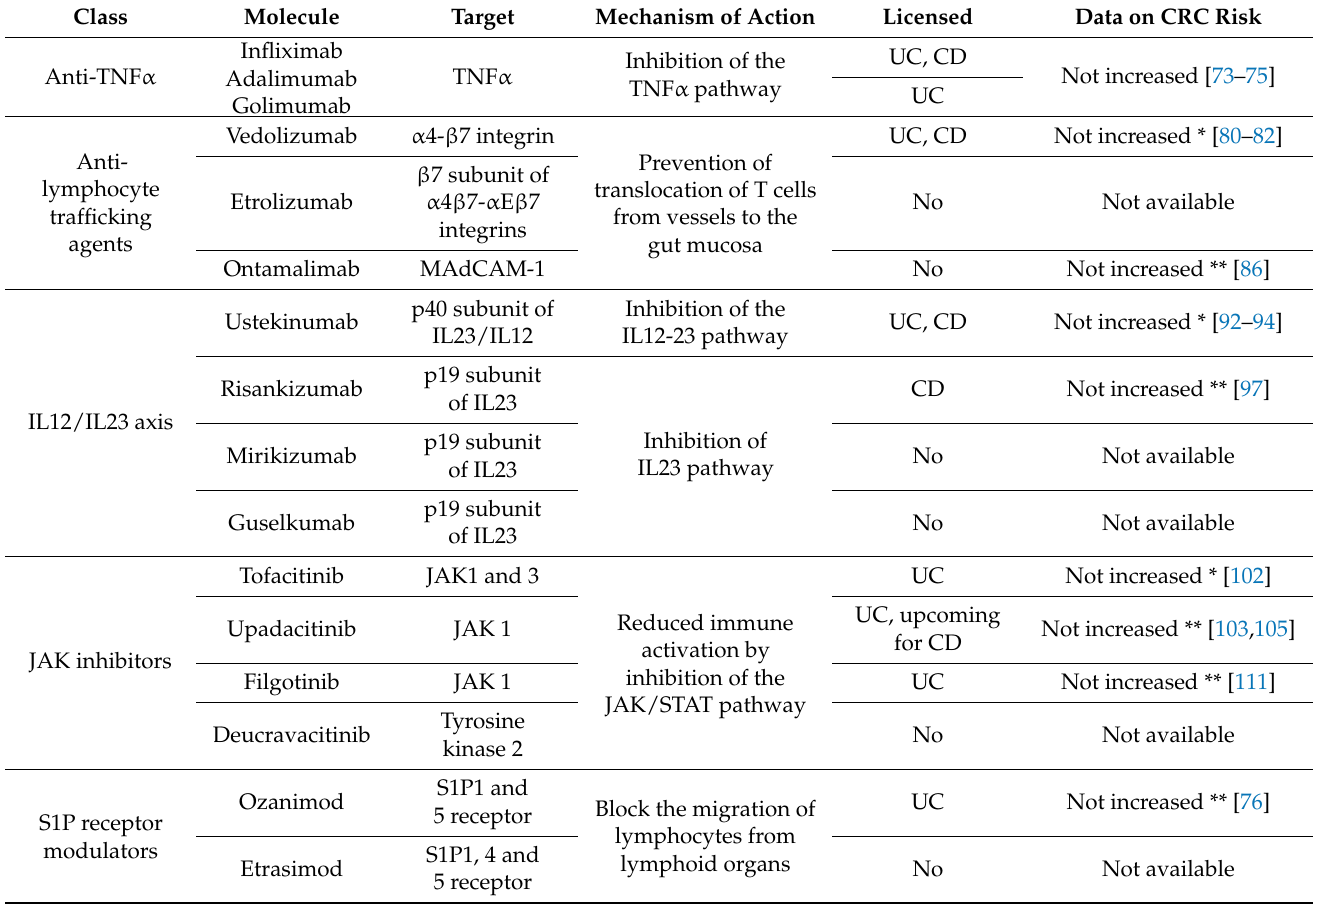
Table 1. Current and upcoming selective therapies for